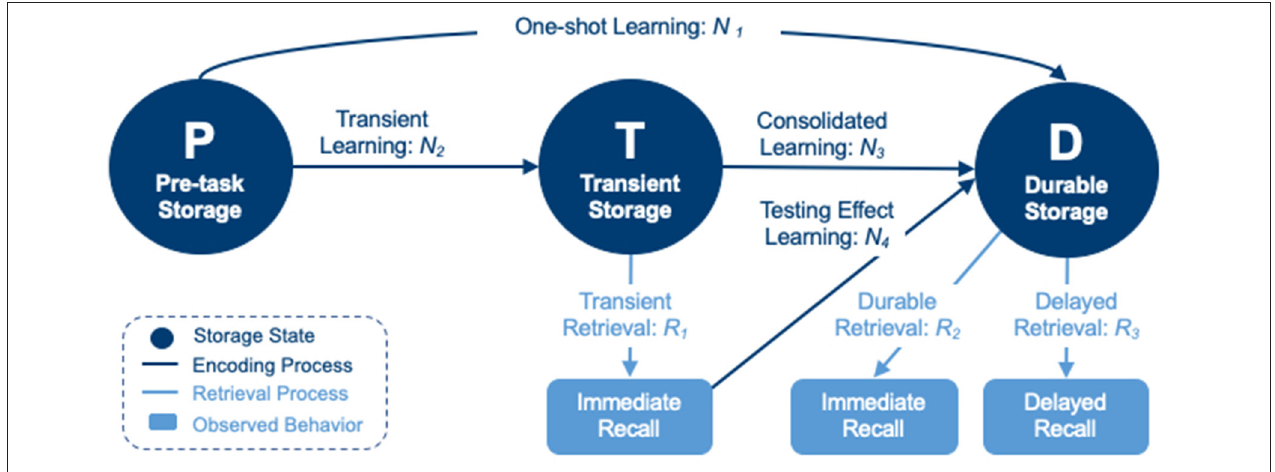
FIGURE 1 | A hierarchical Bayesian cognitive processing model consisting of pre-task (P), transient (T), and durable (D) storage states, connected by encoding processes (N 1 –N 4 ) and retrieval processes (R 1 –R 3 ) into/from states T and